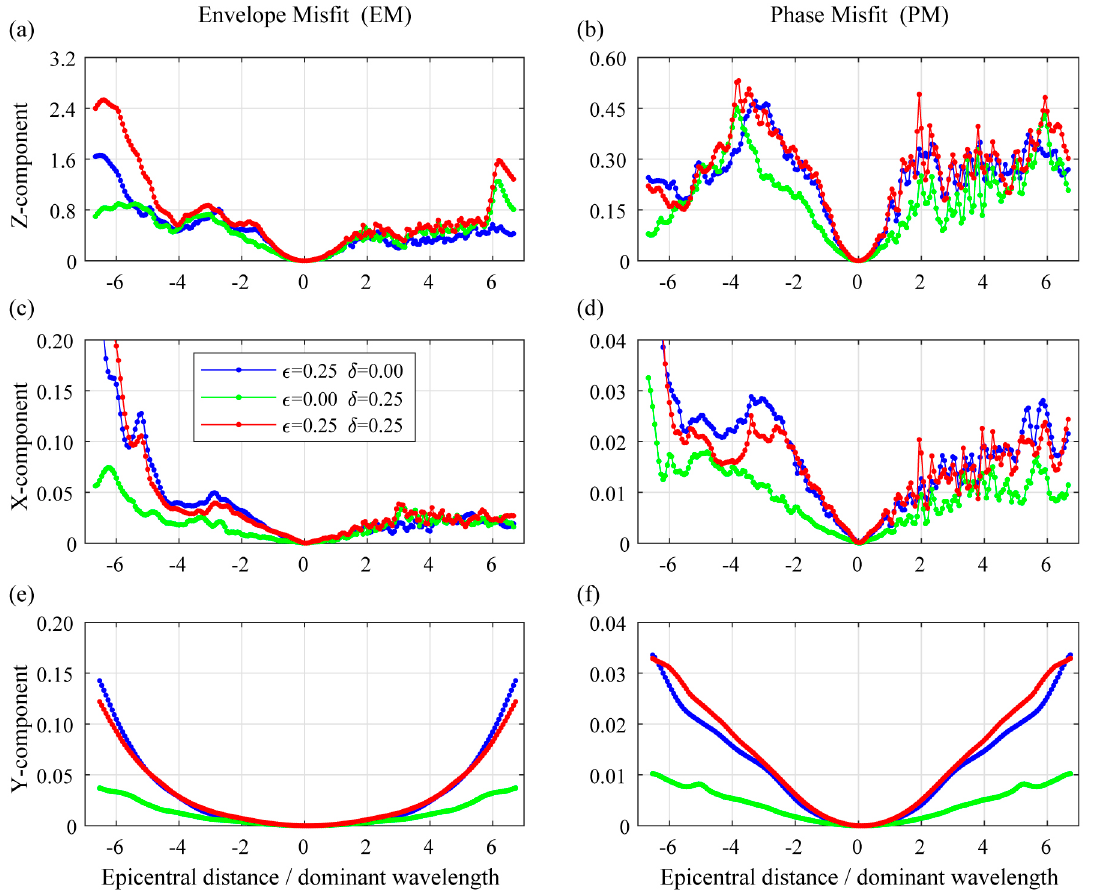
Figure 14. Envelope misfit and phase misfit of detectors’ three-component waveforms (JY model). The meanings of each line and axis are similar to Figure 6.